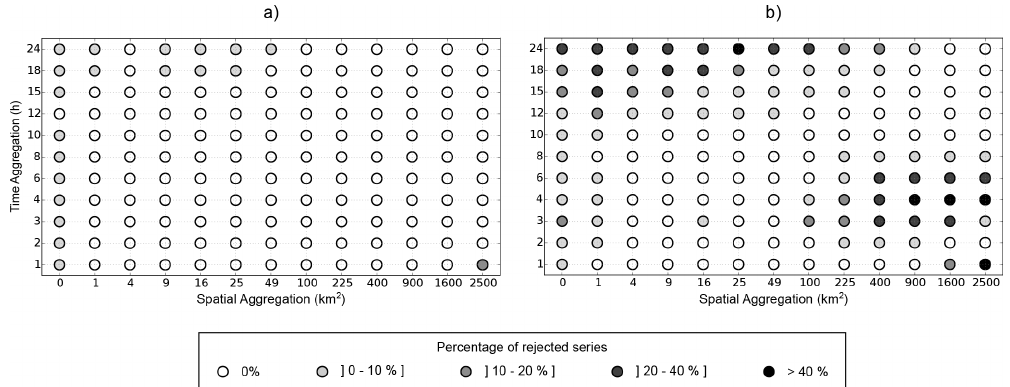
Figure 10. Anderson–Darling GOF test (cross-validation): percentage of rejected series for 1% (a) and 10% (b) significance level for the global IDAF model. Note that there are 30 series for the point scale (0km 2 ) and 13 for the other spatial aggregation